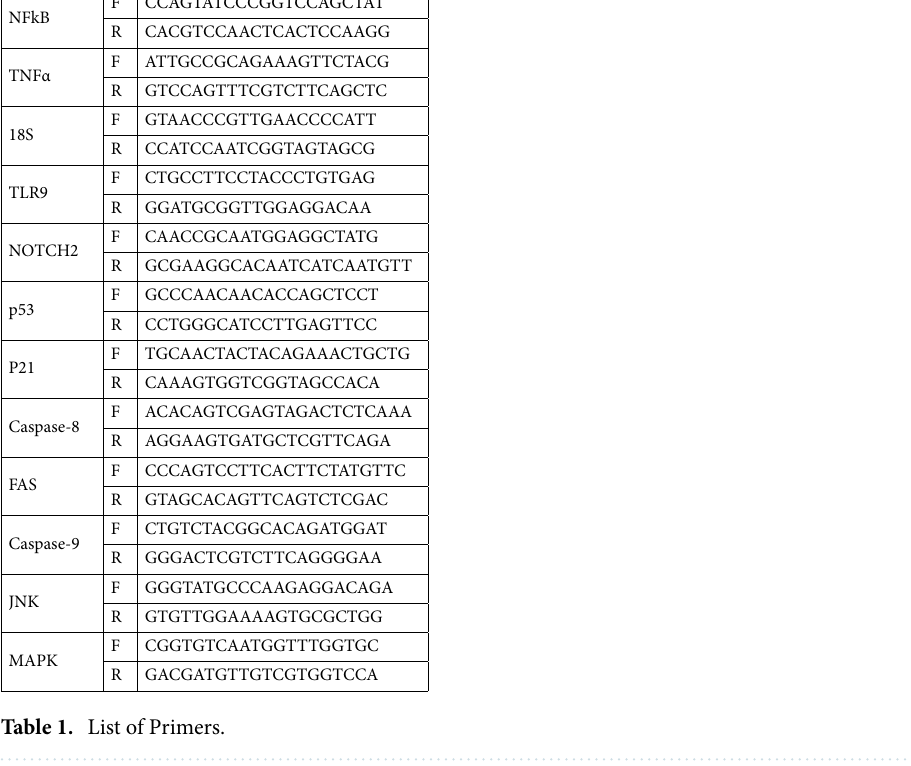
MTS assay for cytotoxicity study.